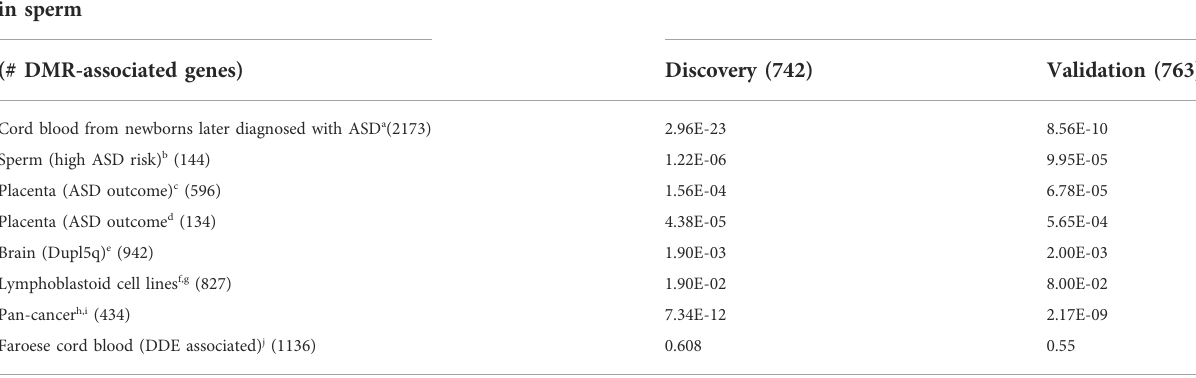
TABLE 6 Overlap among DDE DMR-associated genes and DMRs from different ASD studies and tissues. Samples for comparison of DDE